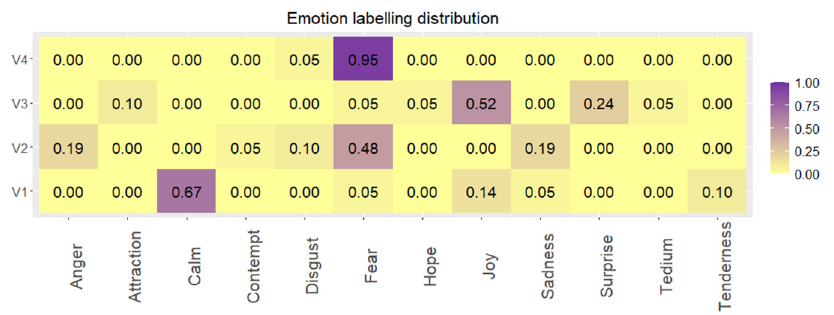
Figure 8. Emotion labelling distribution (0.00–1.00) between emotions reported by the volunteers w.r.t. each video clip visualized.